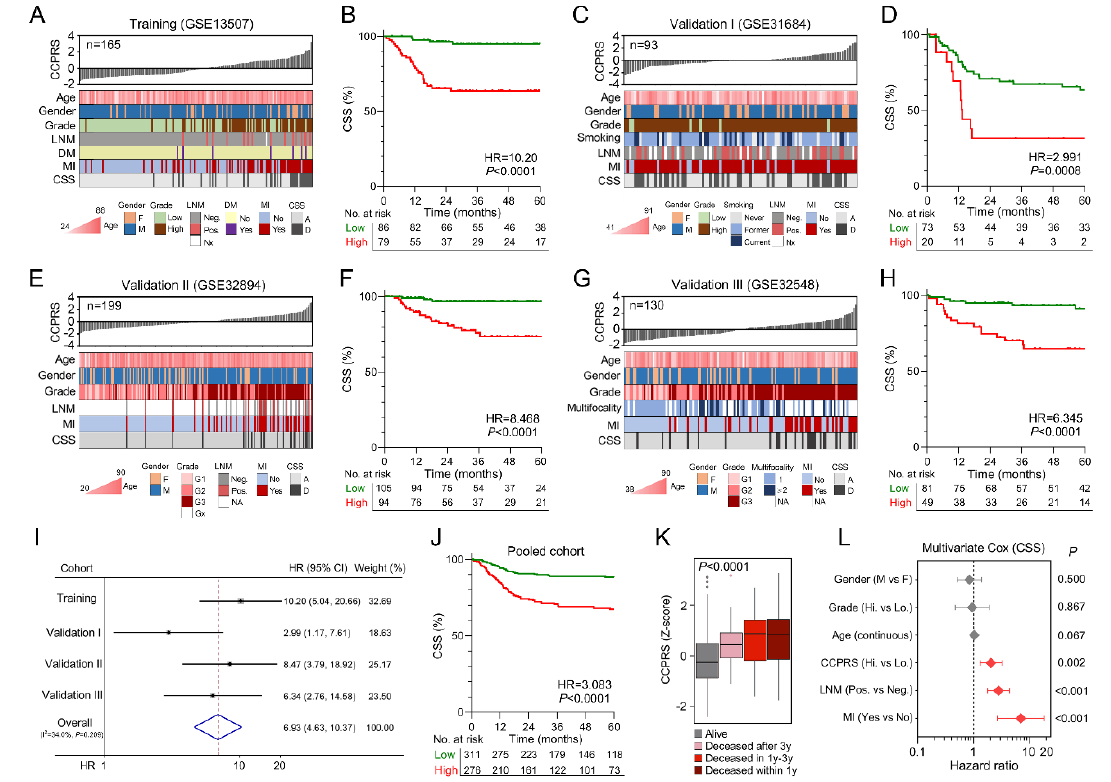
Figure 6. CCPRS correlates with more advanced clinicopathological features and predicts worse CSS. ( A , C , E , G ) Overview of heatmaps depicted associations between CCPRS and different clinicopathological features in each cohort. ( B , D , F , H ) Patients with higher CCPRS exhibited worse CSS in each cohort. ( I ) Meta-analysis on four cohorts included. ( J ) Kaplan–Meier analysis showed that BCa patients with higher CCPRS Z-scores exhibited significantly worse CSS compared to lower scores in the pooled cohort of 587 patients. ( K ) CCPRS Z-scores were significantly elevated in those patients who died during follow-up, with progressively increasing Z-scores as survival time decreased ( p < 0.0001). ( L ) Multivariate Cox regression analysis on a total of 284 patients with full-scale information including CCPRS, gender, grade, age, lymph node metastasis (LNM) and muscle-invasive (MI) status, and results indicated CCPRS was an independent risk factor for CSS along with MI and LNM.